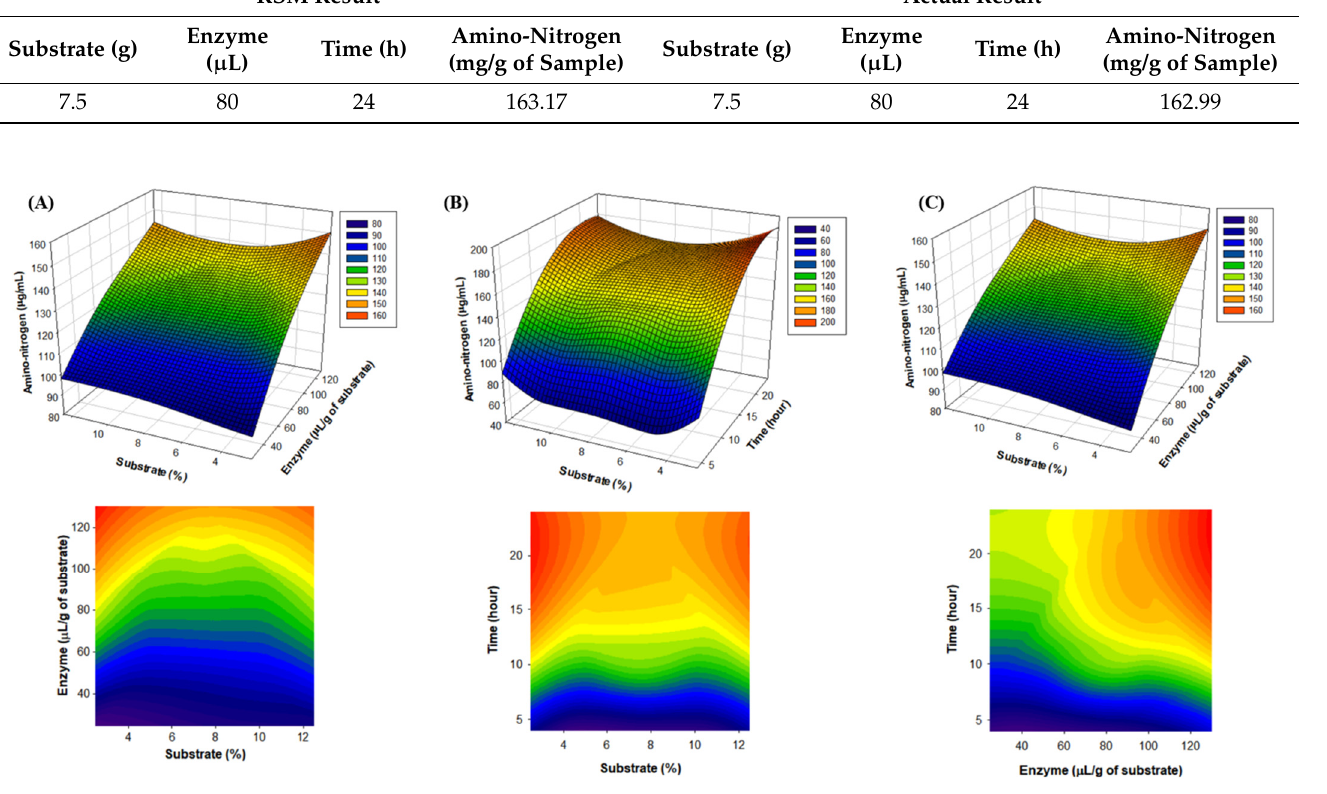
Figure 2. Response surface methodology (RSM)-run 3D graph. ( A ) Substrate (%), enzyme (µL/g of substrate), and amino-nitrogen (µg/mL) 3D graph. ( B ) enzyme (µL/g of substrate), time (hour),